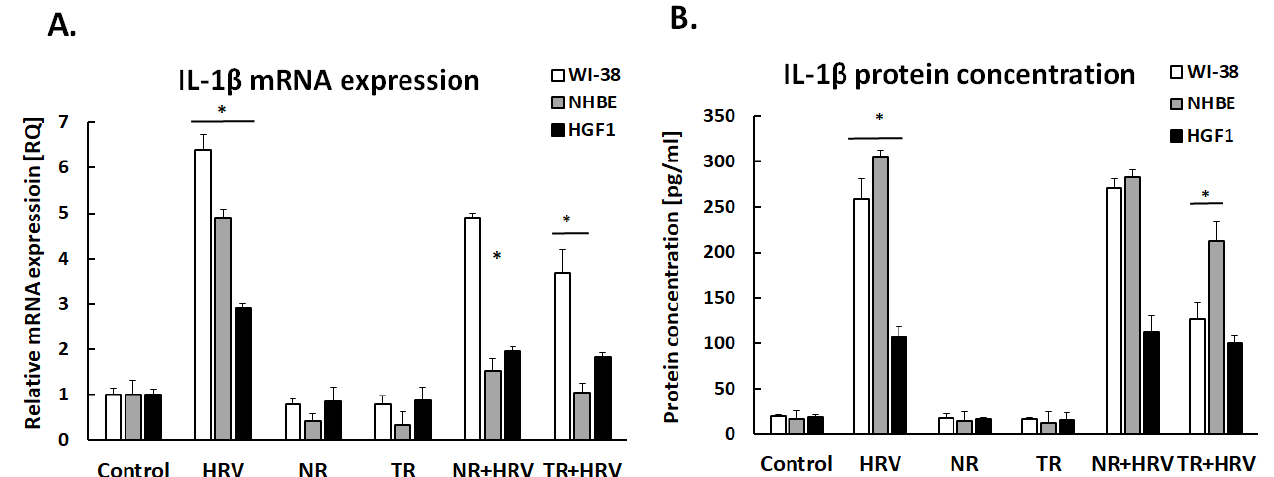
Figure 2. IL-1 β mRNA ( A ) and protein ( B ) expression after treatment with normal (NR) and transformed (TR) Leonotis nepetifolia root extracts following HRV infection. Data presented as mean ± SEM, * p < 0.05.